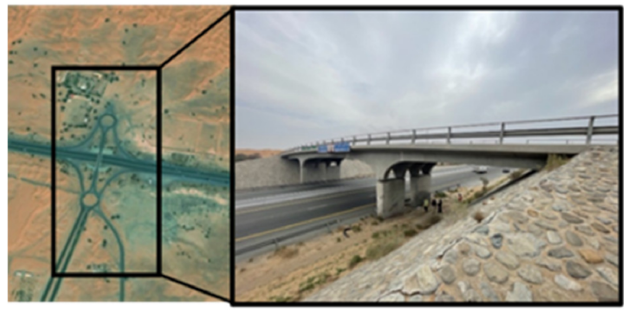
Figure 1. “Interchange 12” bridge.